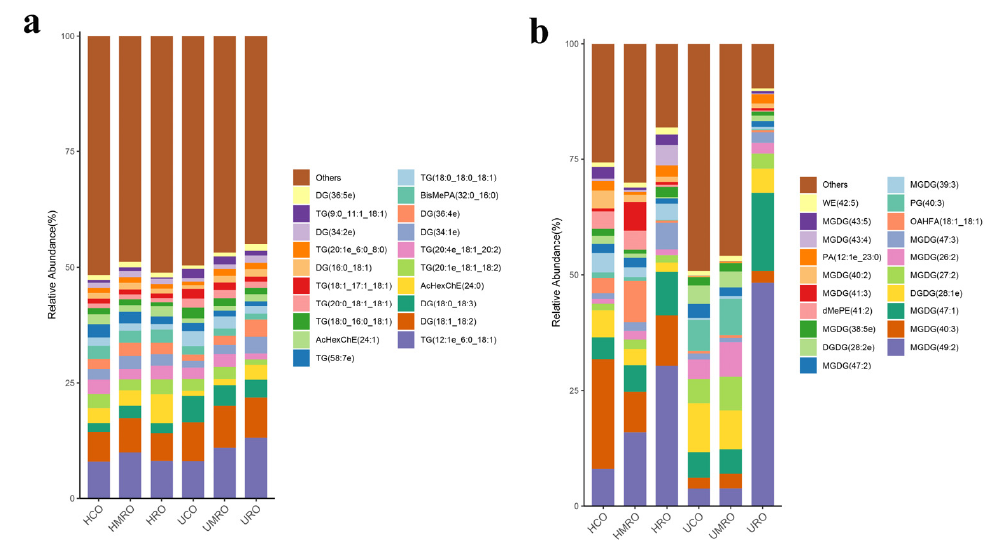
Figure 9. Barplot of camellia oil before and after heating based on non-targeted lipidomics: ( a ) positive ion mode; ( b ) negative ion